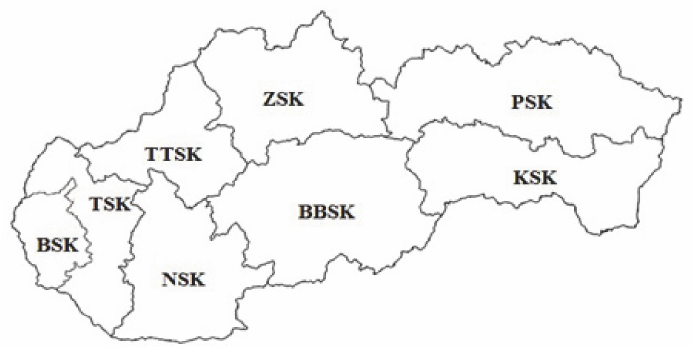
Figure 1. Regions of the Slovak Republic for the purposes of the spatial matrix. Legend: BSK— Bratislava region, TSK—Trnava region, TTSK—Trenˇc í n region, NSK—Nitra region, ZSK—Žilina region, BBSK—Bansk á Bystrica region, PSK—Prešov region, and KSK—Košice region.